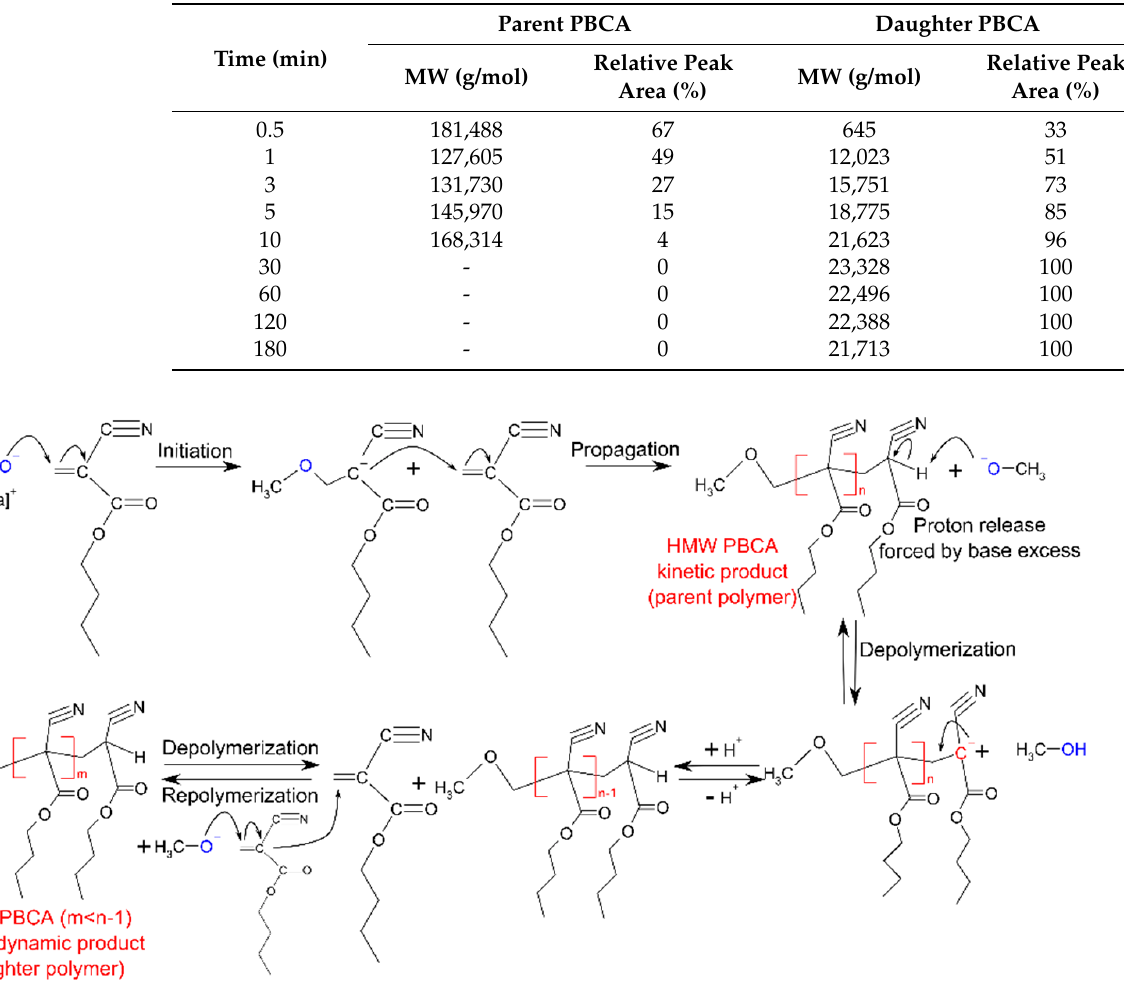
Figure 3. Initiation, propagation and depolymerization–repolymerization steps involved during anionic polymerization of BCA initiated by NaOMe in THF.